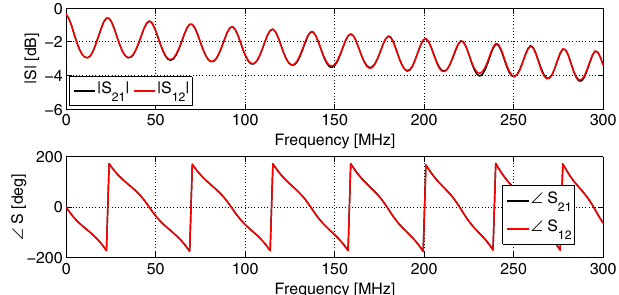
FIG. 5. Modulus and phase of S 21 meas and S 12 meas